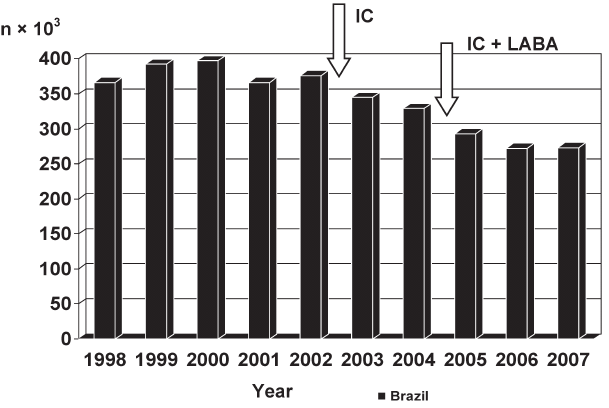
Figure 1 - Hospitalization due to asthma in Brazil as a whole and in Sa˜o Paulo, Brazil in particular, according to data from